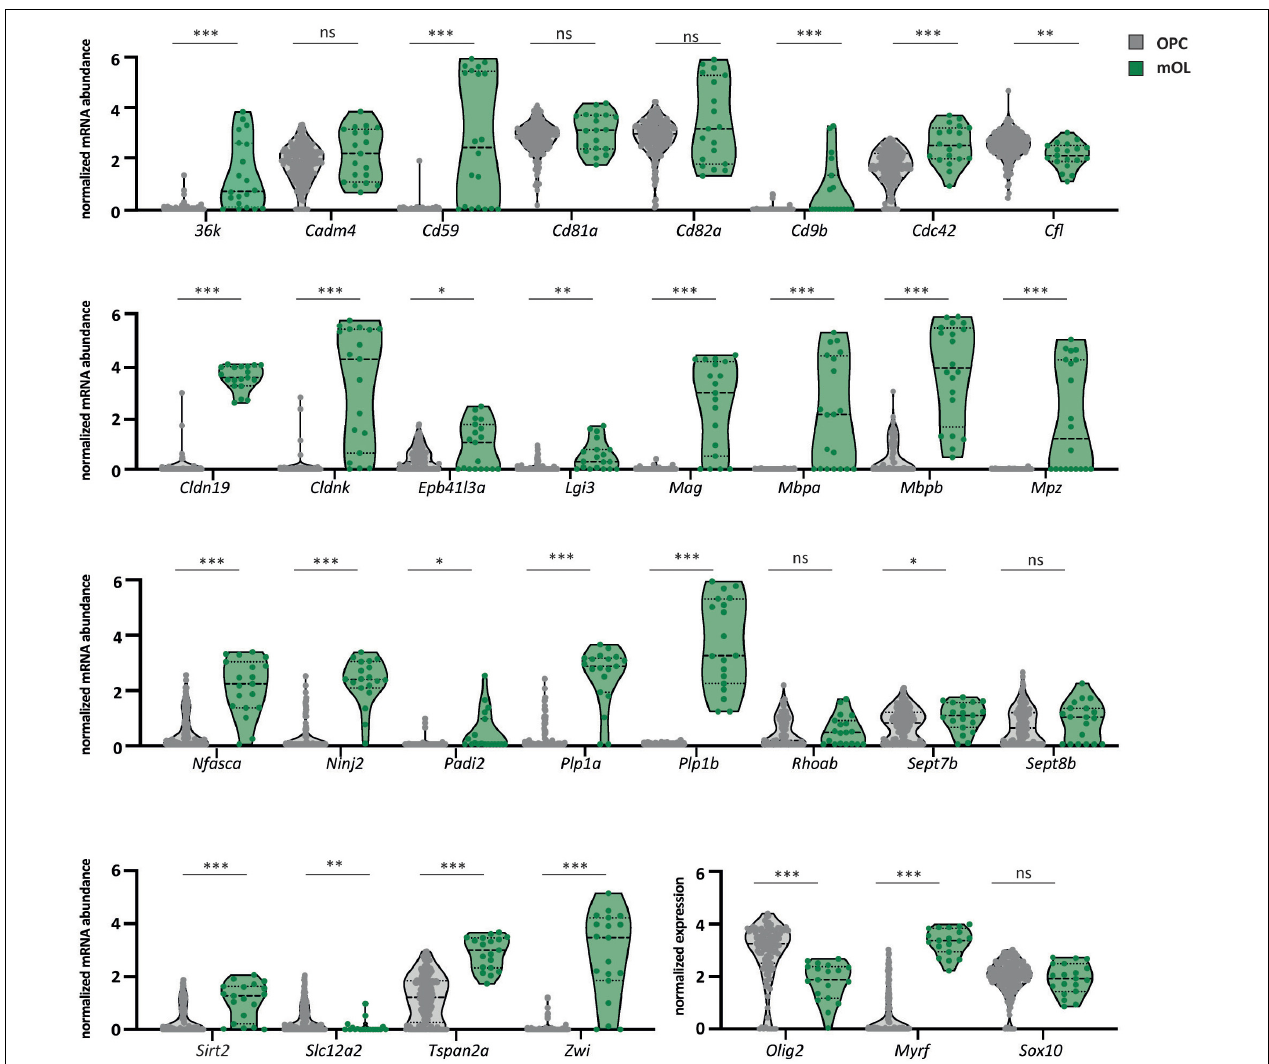
FIGURE 4 | Expression of myelin-related mRNAs in OPCs and mature oligodendrocytes. Violin plots comparing the relative abundance of selected myelin-related transcripts in OPCs and mature oligodendrocytes according to a previously established scRNAseq dataset (Marisca et al., 2020). Data are given as normalized log-transformed mRNA abundance in transcripts per million (TPM) in OPCs (gray) versus mature oligodendrocytes (mOL) (green). Median with interquartile ranges; n = 189 OPCs (combined clusters 1–4 in Marisca et al., 2020) versus n = 19 mOL (cluster 5 in Marisca et al., 2020); ∗ p < 0.05, ∗∗ p < 0.01, ∗∗∗ p < 0.001 by Welch’s t -test. For precise p -values, see section “Materials and Methods.” The mRNAs for oligodendrocyte transcription factor 2 ( olig2 ), myelin regulatory factor ( myrf ), and SRY-box transcription factor 10 ( sox10 ) serve as markers. ns, not significant.